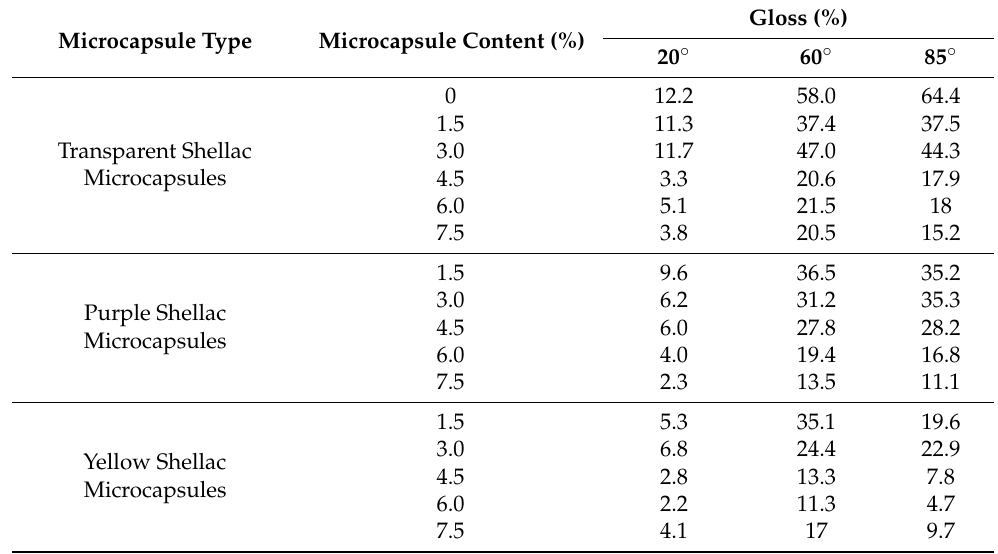
Table 4. The gloss of coating on Beli wood with the content of different shellac microcapsules in the